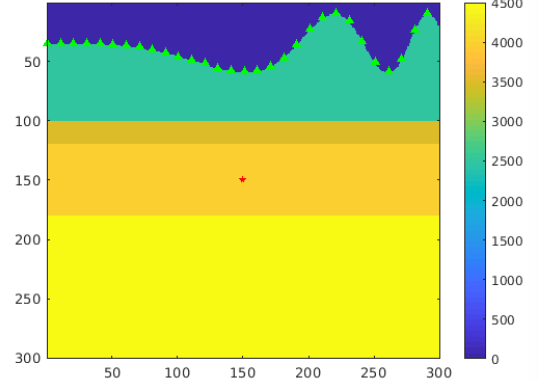
Figure 16. Velocity model with topographic variation. The green triangles are sensors, and the red star is the seismic